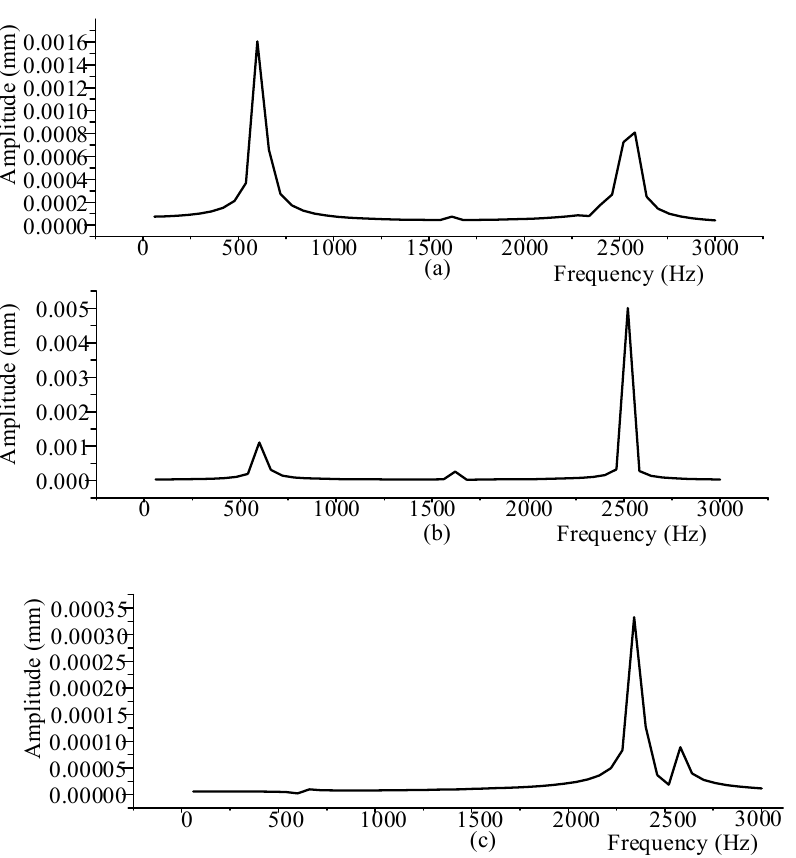
Figure 16. Harmonic response curve of turntable under edge loading: ( a ) X-directional harmonic response curve; ( b ) Y-directional harmonic response curve; ( c ) Z-directional harmonic response curve.